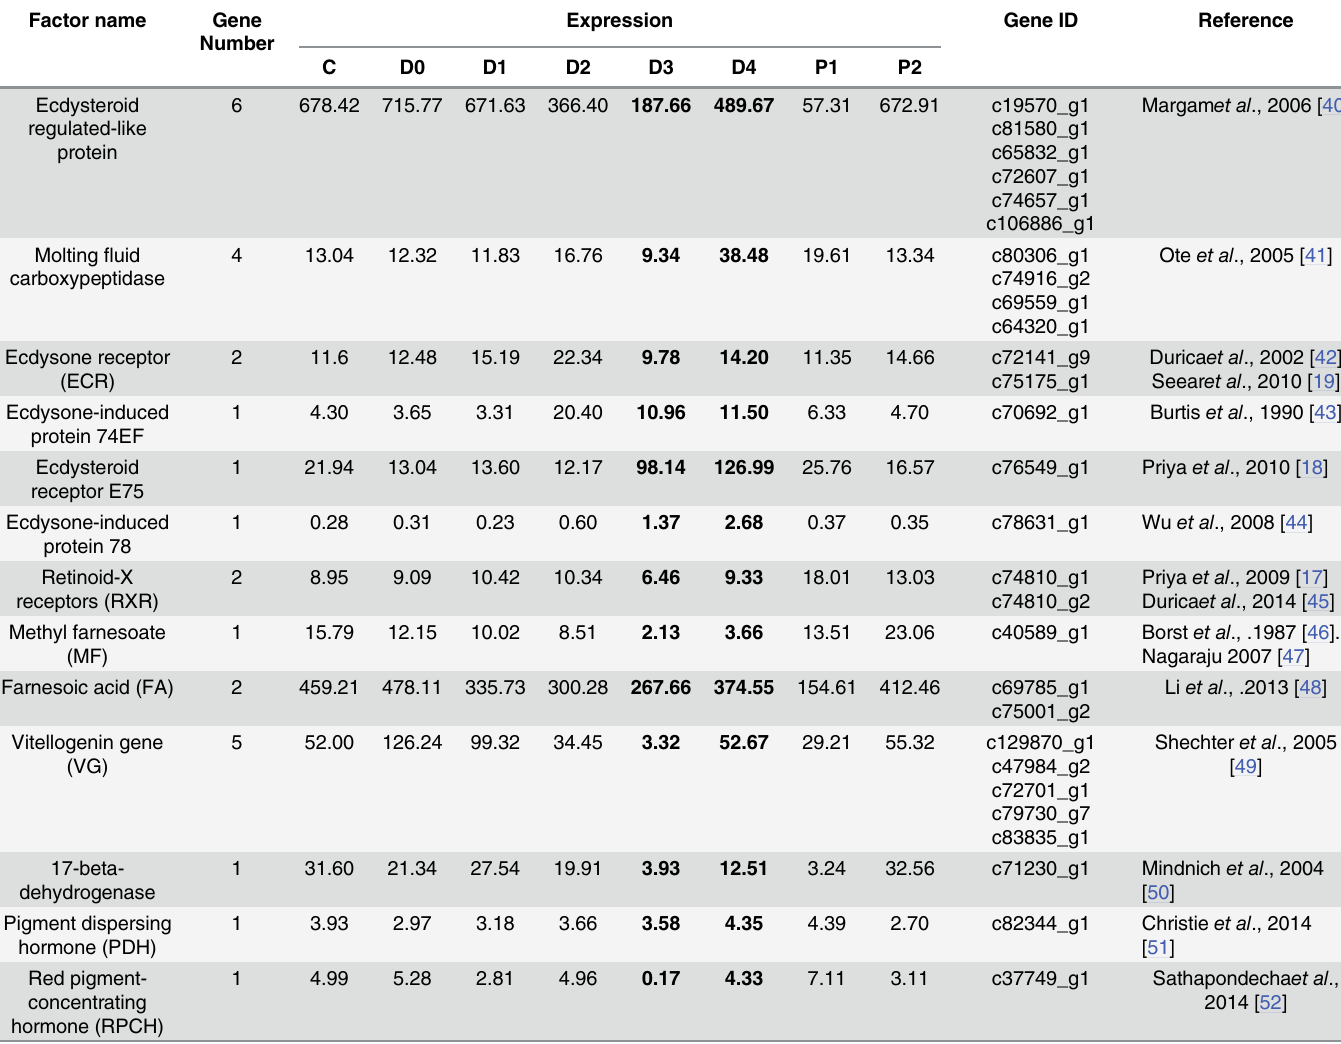
Table 4. Expression levels of hormone related molting